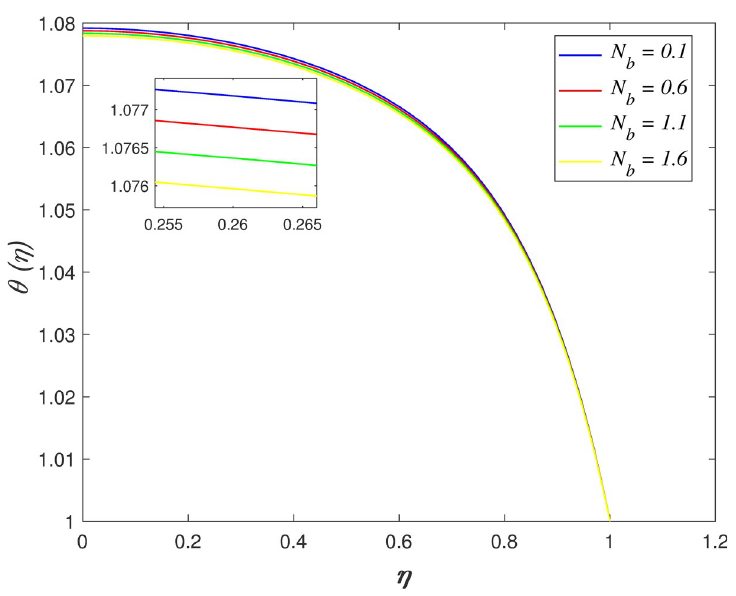
Fig 20. Impact of N b on temperature.